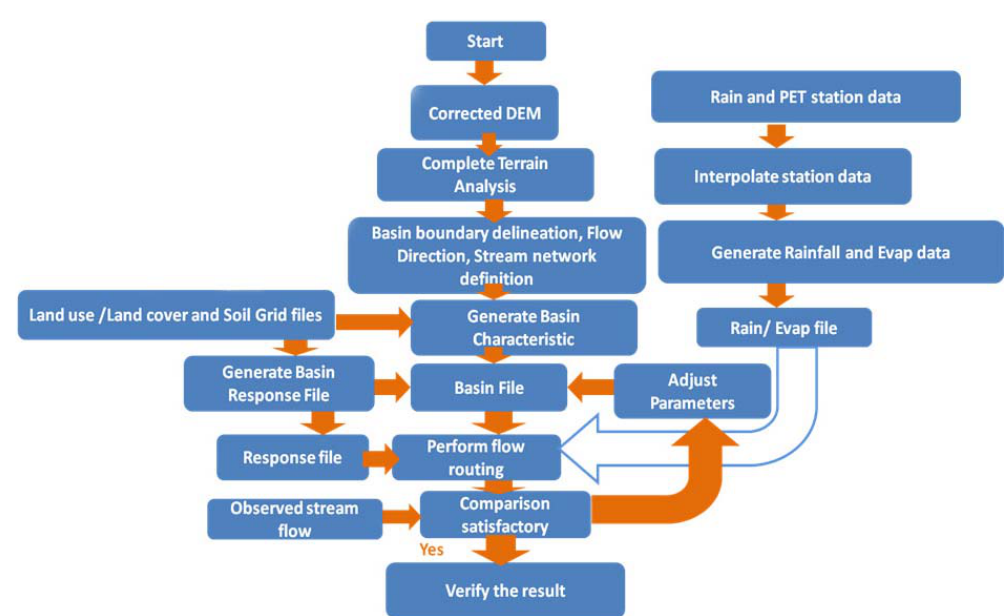
Figure 2. Flow chart of the modeling process, inputs and outputs. Fig. 2. Flow chart of the modeling process, inputs and outputs.